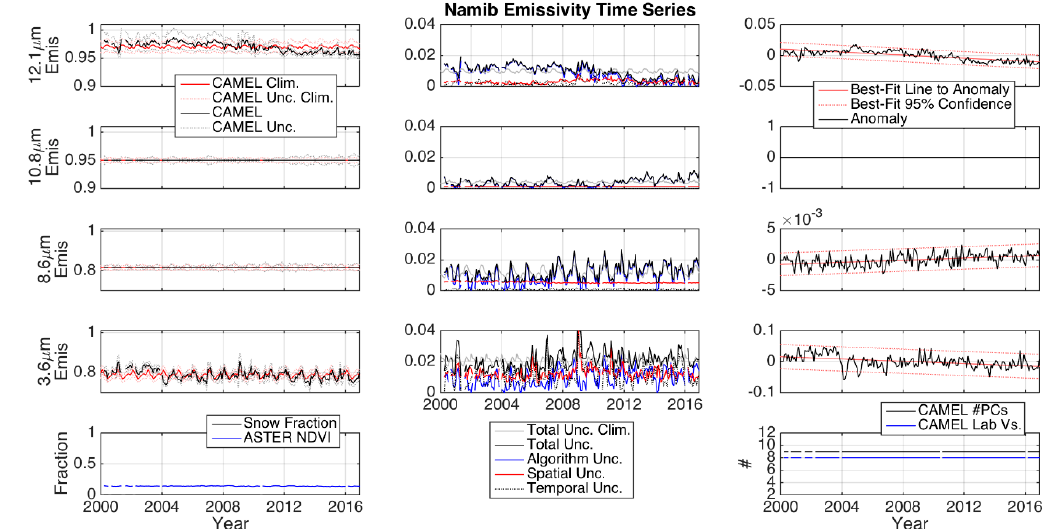
Figure 5. Same as Figure 4 except for the Namib Desert quartz site.